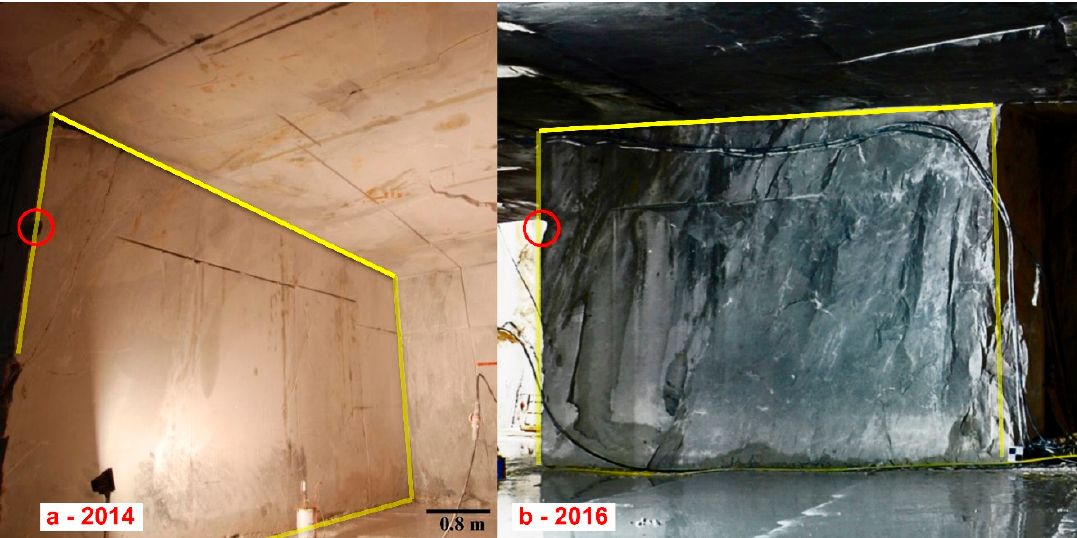
Figure 1. Pillar structural condition in 2014 ( a )—regular rocky surface after excavation) and 2016 ( b )—rough rocky surface after spalling). The yellow box represents the same cutting surface. A common point between the images is highlighted by a red circle. Due to the prospective view, the scale bar is indicative only.